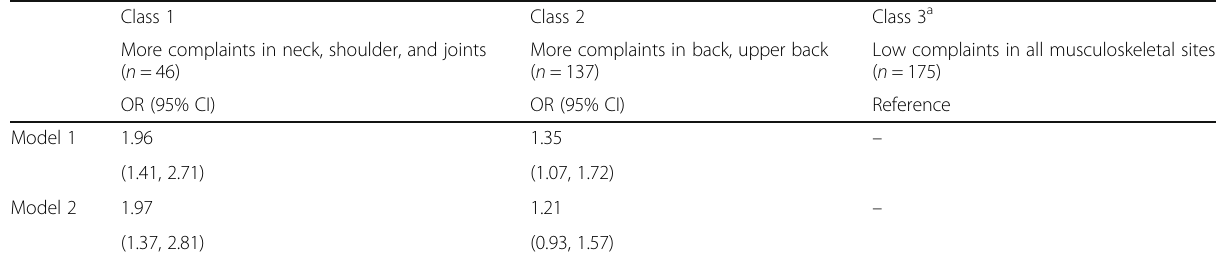
Table 3 Association of latent class-derived patterns of MSD and psychological problems score Class 1